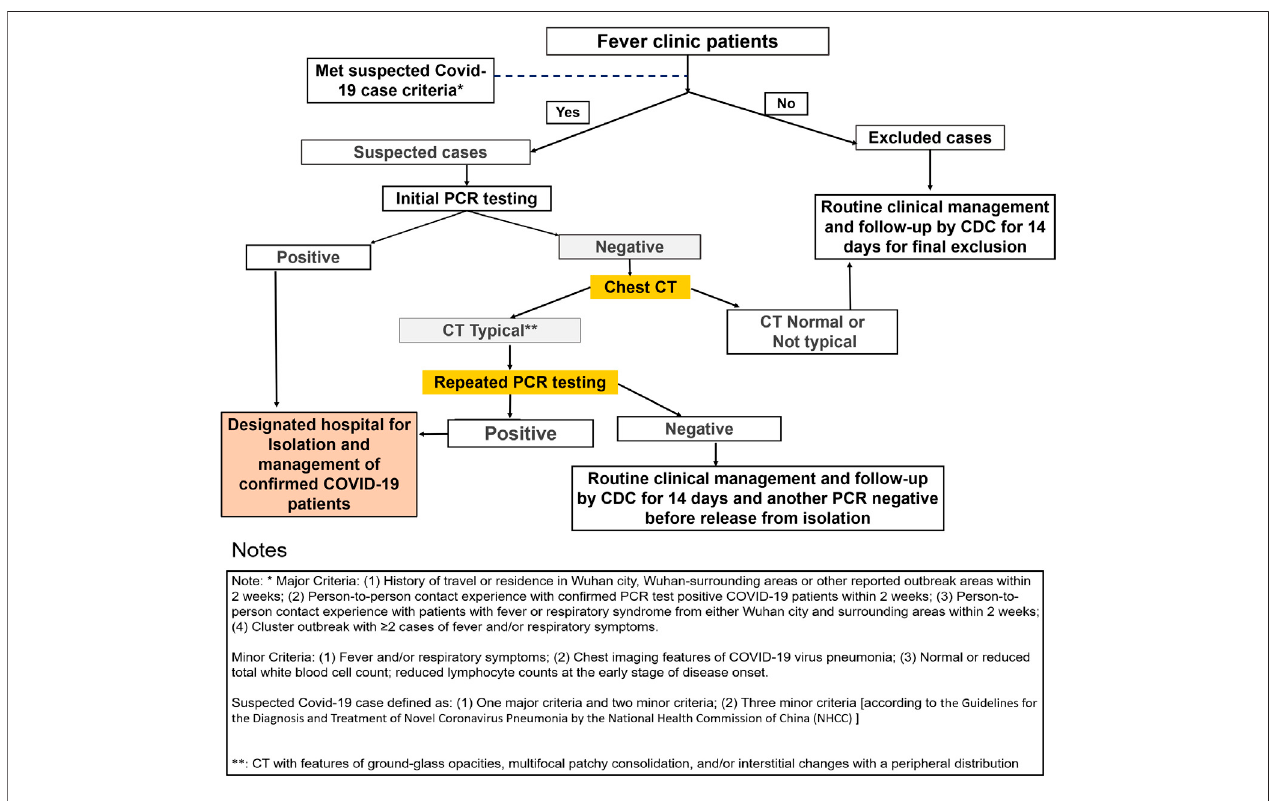
FIGURE 1 | Fever clinic patients were ef fi ciently triaged and diagnosed for COVID-19. The false-negative rate for initial PCR testing is 30.8% (4 out of 13). A high percentage (8.9%) of the initial PCR testing – negative patients with typical CT signature were con fi rmed to be COVID-19 positive after repeated testing. Initial PCR testing – negative results but chest CT – positive results for viral pneumonia urges for repeated testing for COVID-19